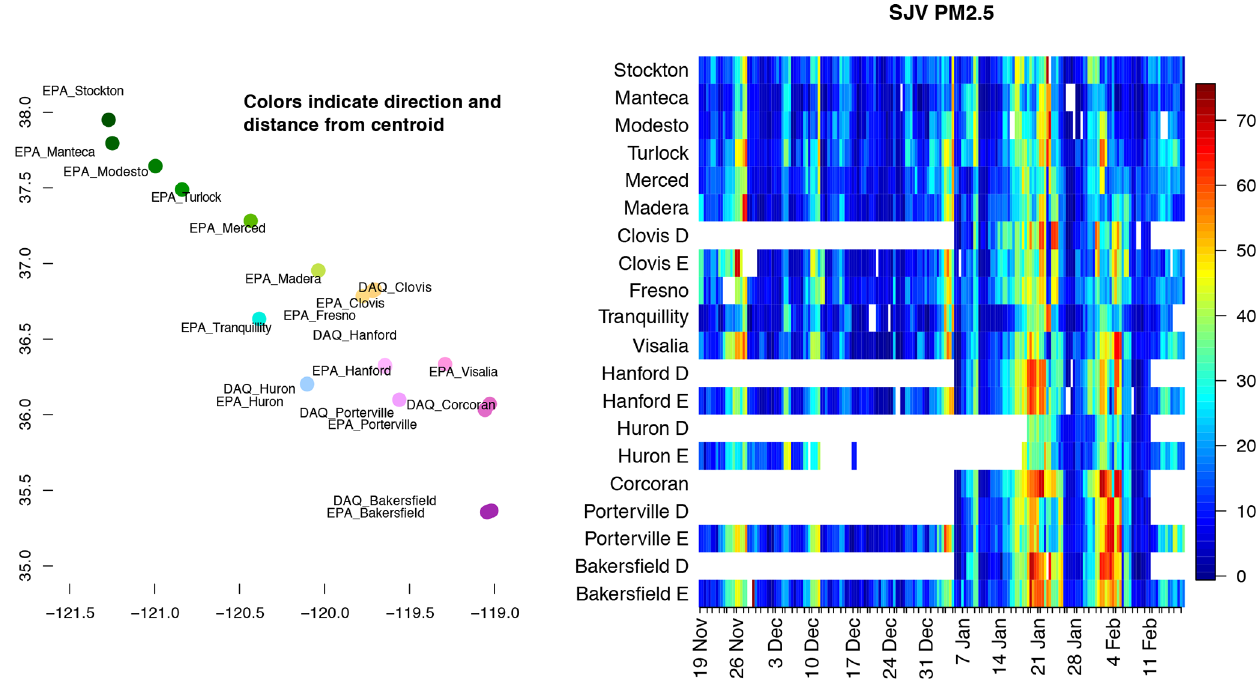
Figure 3. (a) Locations of stations in the SJV used; color coding allows nearby stations to be identified. (b) Matrix plot of PM 2 . 5 as measured at all instances of overpass at the sites for the period 19 November 2012 through 18 February 2013. The x axis has variable spacing in time; tick marks indicate successive days. Another view that summarizes the variability of observed PM 2 . 5 is shown in Fig.